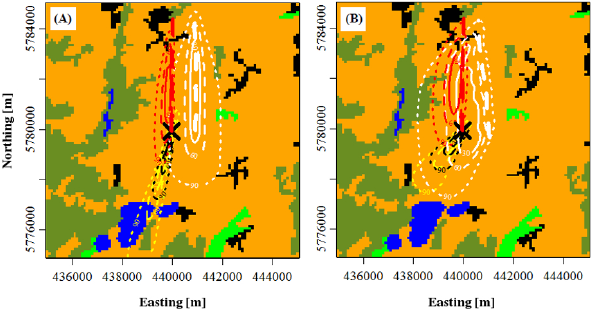
Fig. 9. Footprint effect levels of the measurements from Fig. 8 on 20 October 2008 (A) and 21 October 2008 (B) , presented similarly to Fig. 7. In addition, the weighted footprint along the LAS path is shown (red), and the footprints from the tower measurements at 50m (black) and 90m (yellow) are